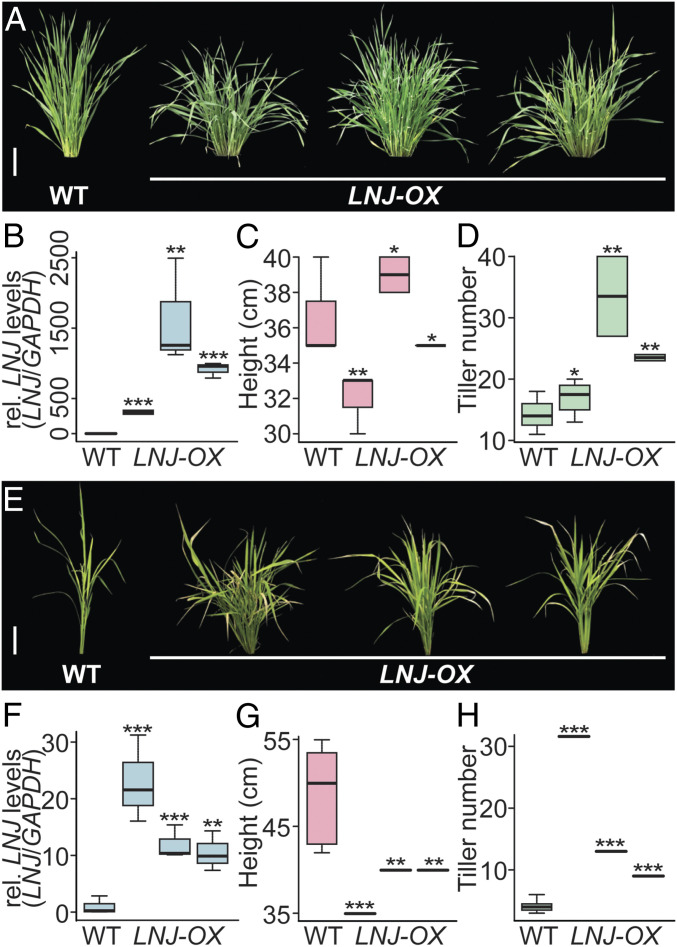
LNJ influences shoot architecture of crop plants. (A) Picture of 2-mo-old barley plants. Wild-type barley (H. vulgare cv. Golden Promise) and three independent LNJ-OX lines grown under LD photoperiod (20/15 °C, 16 h light/8 h dark). (Scale bar, 10 cm.) (B) Relative expression levels of LNJ mRNA in wild-type and independent T2 transgenic plants which were determined by qRT-PCR. Expression levels, normalized against barley GAPDH gene, are depicted as box plots; n = 3. (C and D) Quantification of height (C) and tiller number (D) are depicted as box plots in wild-type and three independent LNJ-OX lines grown under LD photoperiod. n = 8 to 15. (E) Picture of 3-mo-old representative rice plants. Wild-type rice (Oryza sativa cv. Nipponbare) and three independent LNJ-OX lines grown under SD photoperiod (28/25 °C, 12 h light/12 h dark). (Scale bar, 10 cm.) (F) Relative expression levels of LNJ mRNA in wild-type and independent T0 transgenic plants which were determined by qRT-PCR. Expression levels, determined as relative quantities and normalized against rice ACTIN gene, are depicted as box plots; n = 3. (G and H) Quantification of height (G) and tiller number (H) are depicted as box plots in wild-type and three independent LNJ-OX lines grown under SD photoperiod. *P < 0.05, **P < 0.005, ***P < 0.0005 determined by Student’s t test.